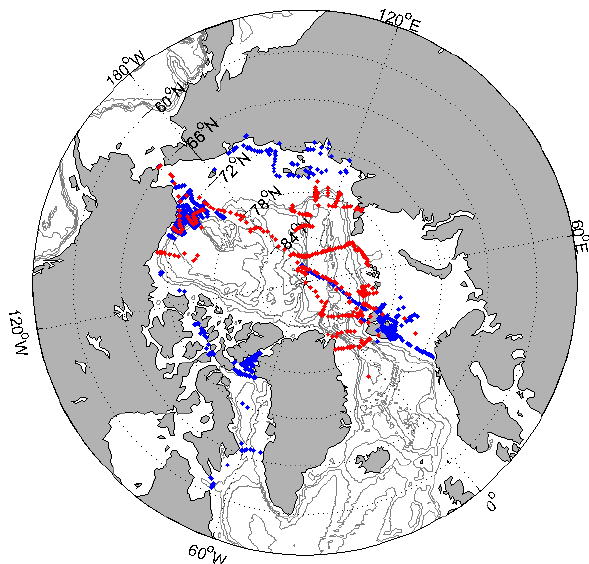
Figure 1. Map of all station locations of cruises included in Table 1, all station locations of the cruises included in the secondary QC are labelled